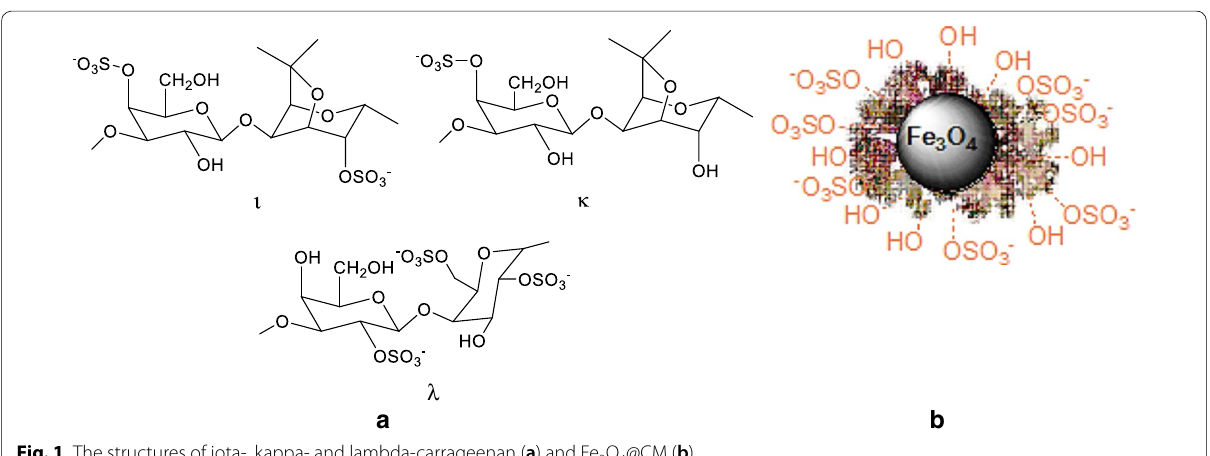
Fig. 1 The structures of iota-, kappa- and lambda-carrageenan ( a ) and Fe 3 O 4 @CM ( b )